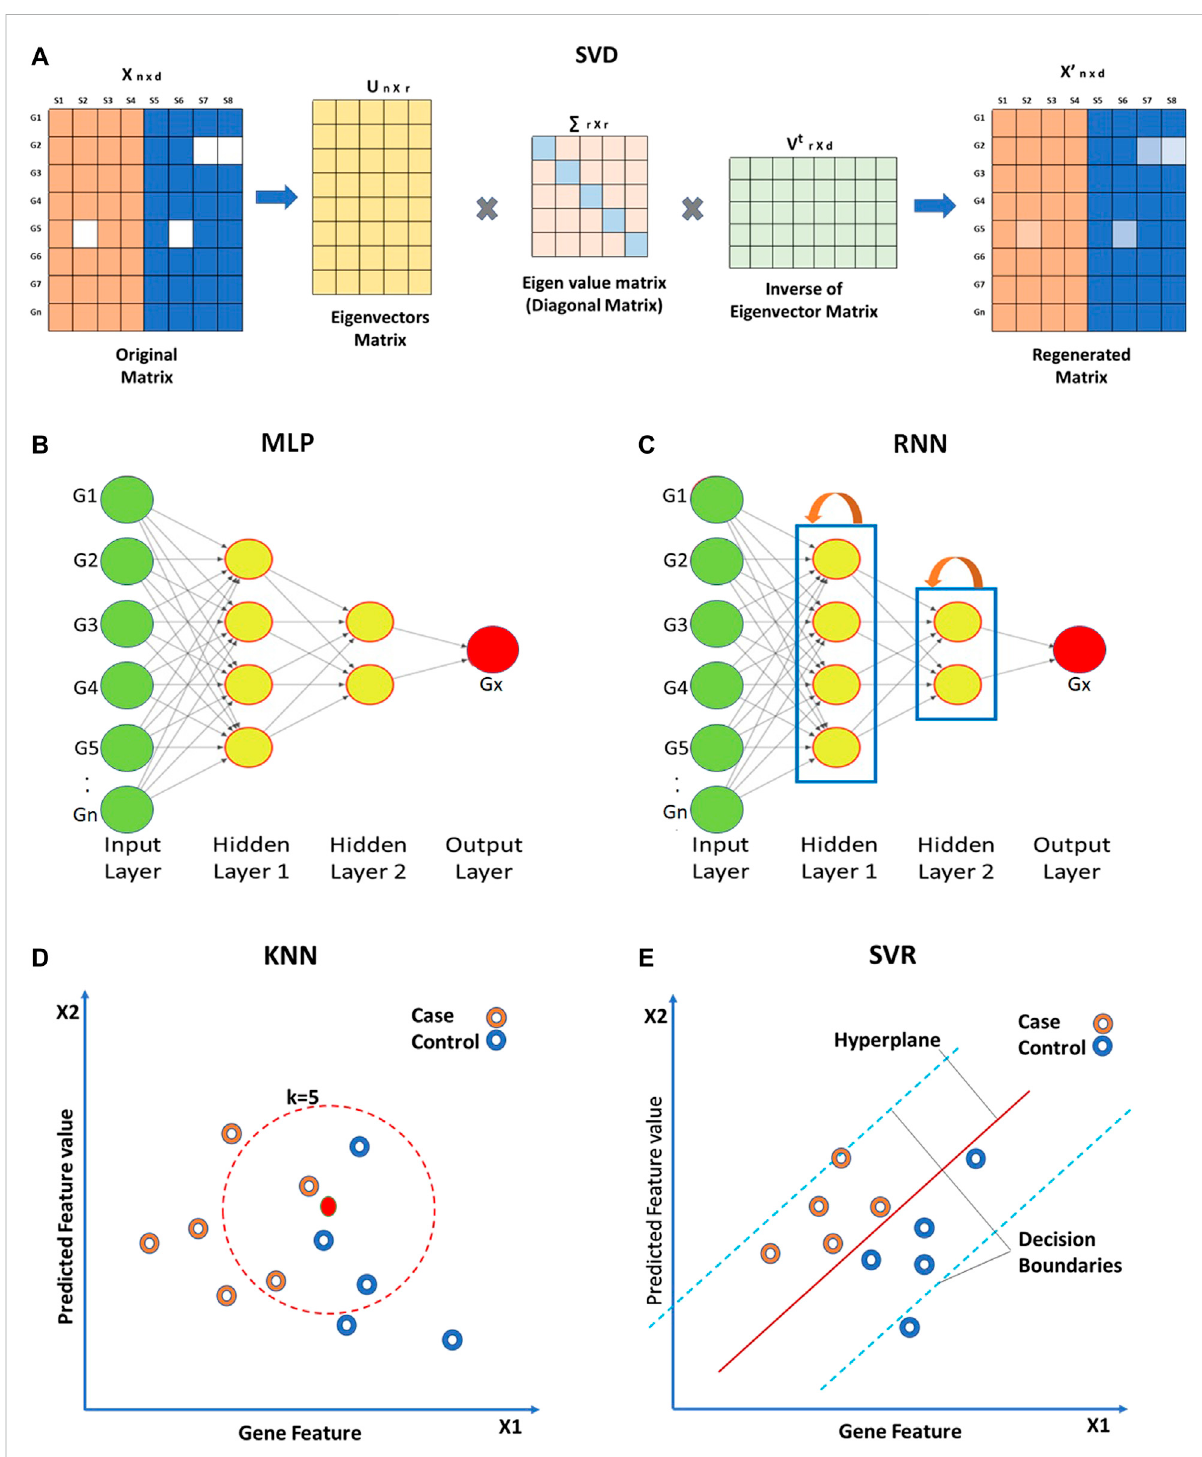
FIGURE 4 Approaches for missing value imputation. Global approaches such as (A) Singular value decomposition (SVD), (B) Multi-layered perceptron (MLP), and (C) Recurrent Neural Network use global correlation information extracted from gene expression array to estimate missing values. Local approachessuchas (D) K-nearestneighbor(KNN)and (E) Supportvectorregression(SVR)utilizelocalsimilarityinthegeneexpressiondata.Thesolid green circles in (B,C) represent known gene expression values and solid red circles represent missing ones. Hollow circles in (D,E) represent